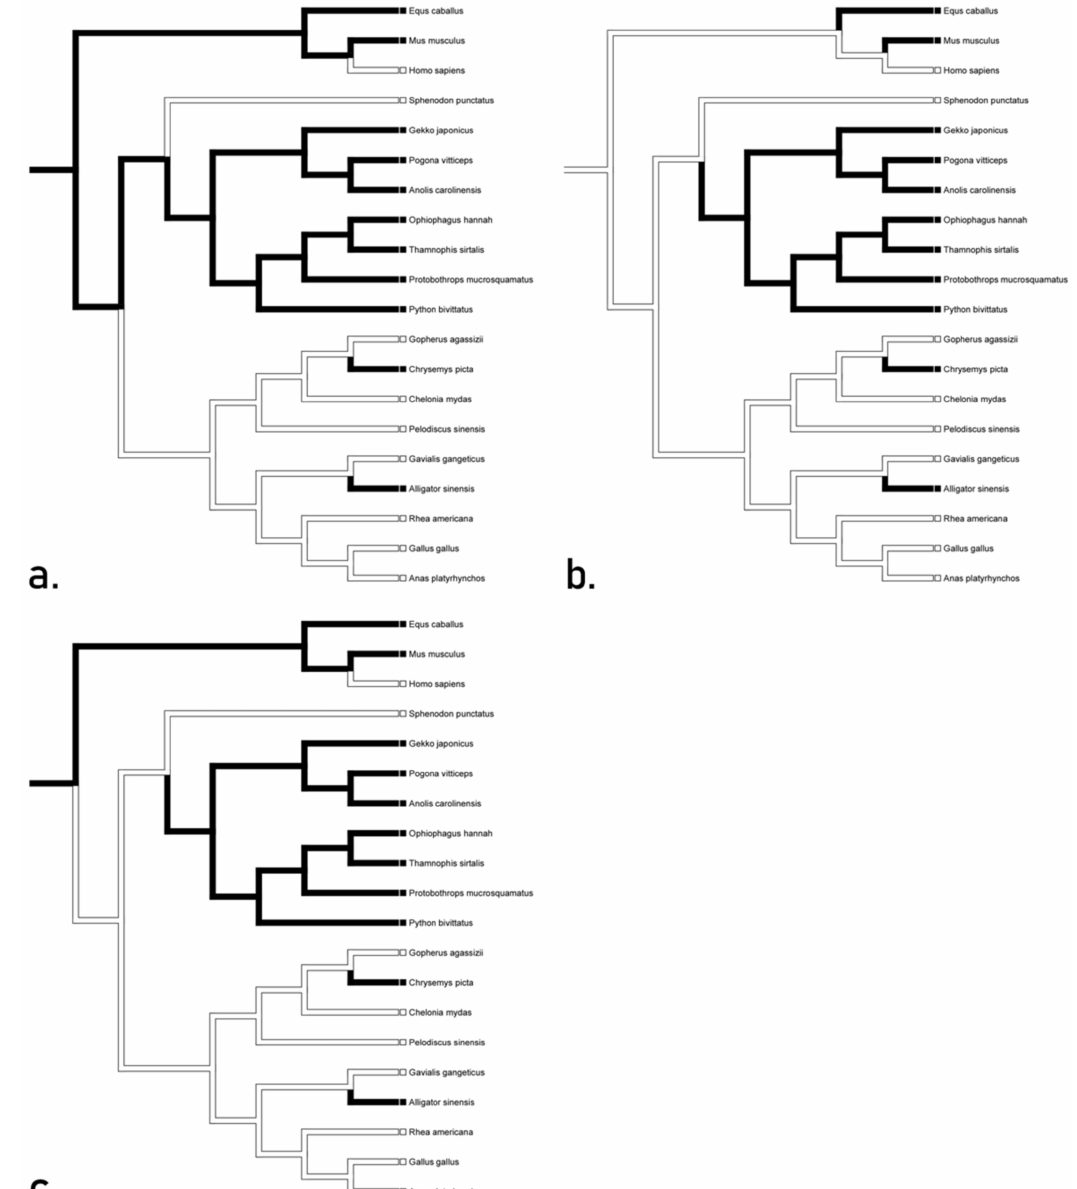
Figure 3. Character optimization of TLR 13 using accelerated ( a ) delayed ( b ), and mixed ( c ) transfor- mations supporting convergence between Chrysemys and Alligator for the gene in all three proposed trees, as well as a loss in Sphenodon . Accelerated transformation suggests conservation in squamates and convergence between Chrysemys and Alligator , while delayed and mixed transformations suggest a reversal for the gene in